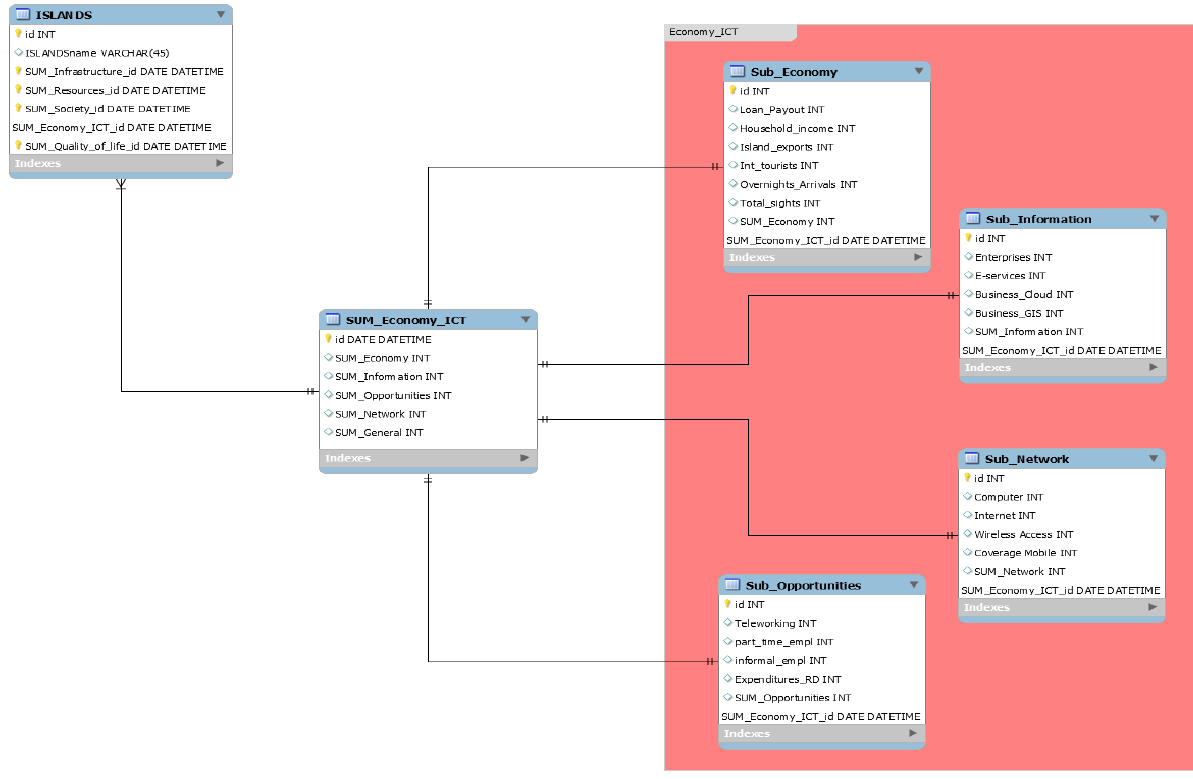
Figure 4. Relation between the entities of the second circle: e.g. the entity Economy is related with the following entities: Opportunities, Economy, Information, Network.